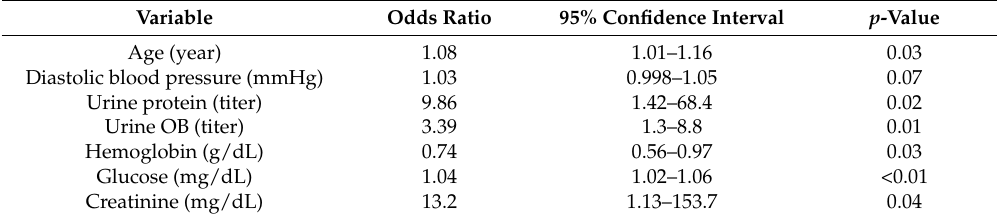
Table 2. Multivariate logistic regression modeling with annual eGFR change < 0 mL/min/1.73 m 2 as the dependent variable.